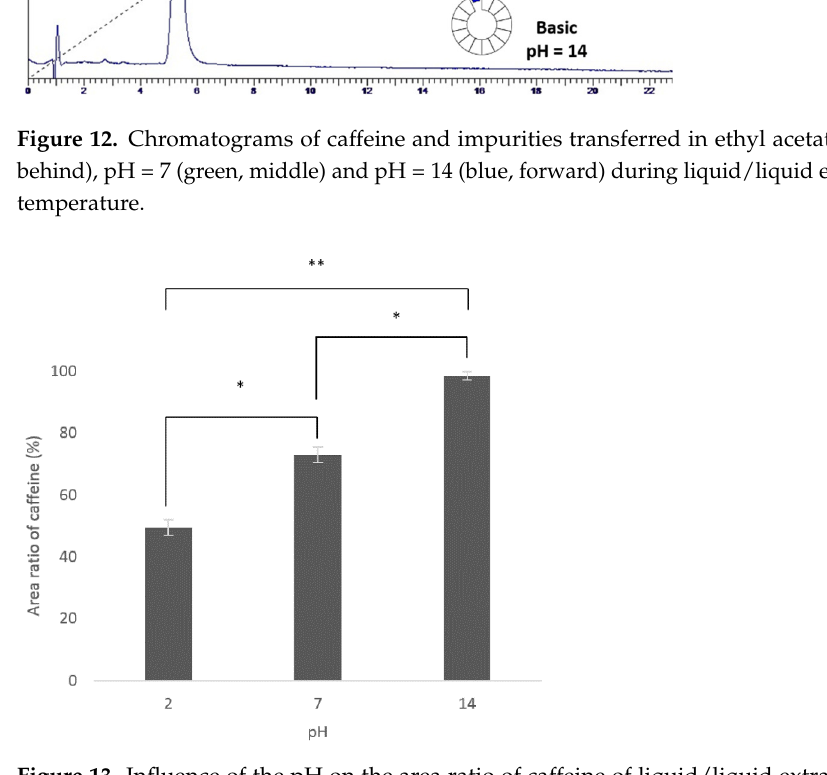
Figure 13. Influence of the pH on the area ratio of caffeine of liquid/liquid extraction of aqueous extract (60 mL) treated with ethyl acetate (60 mL) at room temperature. Values marked by the symbol * are significantly different ( p < 0.05) according to the Student test ( t- test). Values marked by the symbol ** are significantly different ( p < 0.01) according to the Student test ( t- test).